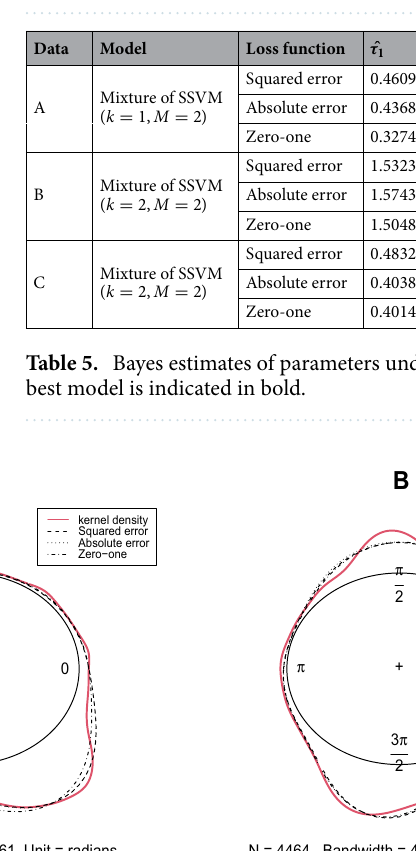
Figure 8. Kernel density plots of datasets and fitted curves based on MLEs.